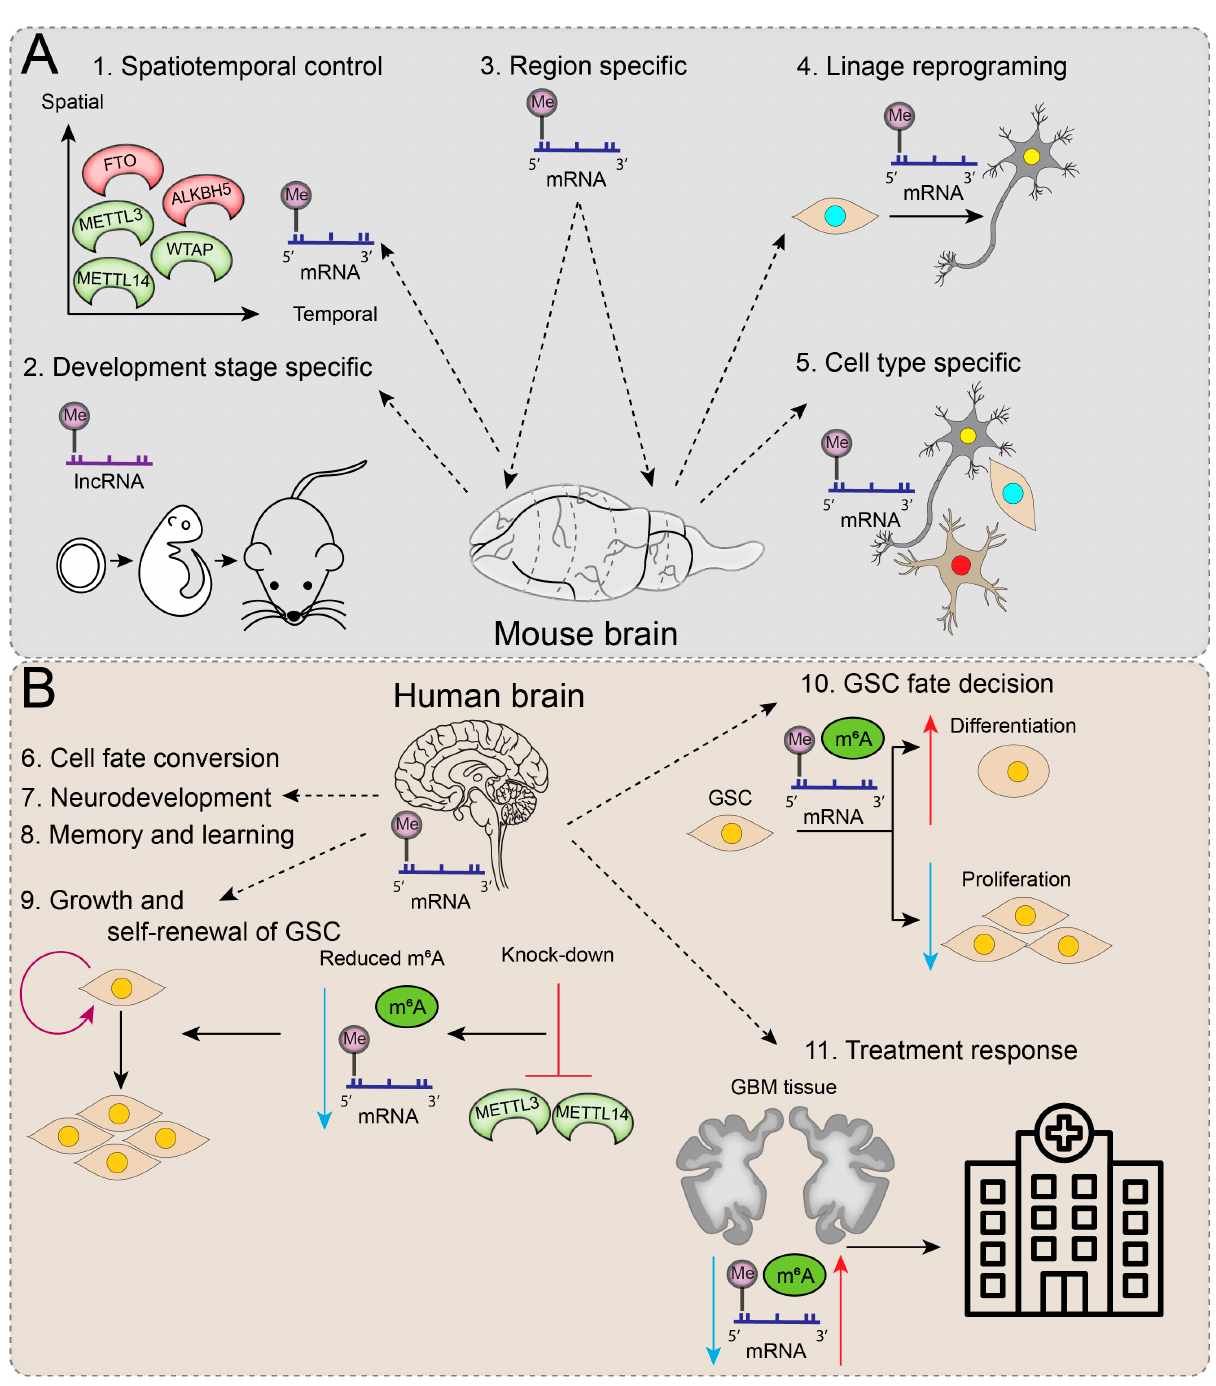
Figure 2. Functions of epitranscriptomic regulators and RNA modifications in the brain. ( A ) In an animal model (mouse), RNA methylation is predominantly related to spatiotemporal control and is specific to developmental stage, region, lineage, and cell type. ( B ) The main functions attributed to RNA methylations in the human brain are associated with cell fate conversion, neurodevelopment, memory, and learning. The knockdown of m 6 A ‘writers’ (METTL3 and METTL4) causes a decrease in m 6 A methylation, which is thought to play a role in GSC growth and cell renewal. The m 6 A meth- ylation levels can influence the GSC fate decision towards differentiation (increase; red upward ar- row) or proliferation (decrease; blue downward arrow). RNA modifications detected in GBM tissue reflect treatment-related responses, which could have great importance for clinical monitoring of GBM. During gliogenesis, when neural stem cell (NSC) populations are replaced by glial, astrocyte, and oligodendrocyte precursor cells (GPC, APC, and OPCs, respectively) [78], several m 6 A methylation-related changes take place. This was evidenced by Mettl3 and Mettl14 knockouts in embryonic mice brains, leading to ablation of RNA m 6 A levels and